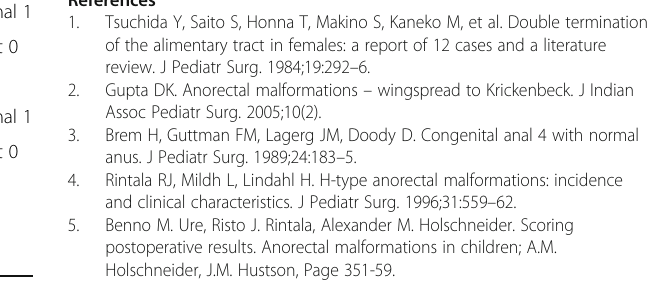
Table 4 Kelly ’ s scoring chart Degree of fecal incontinence